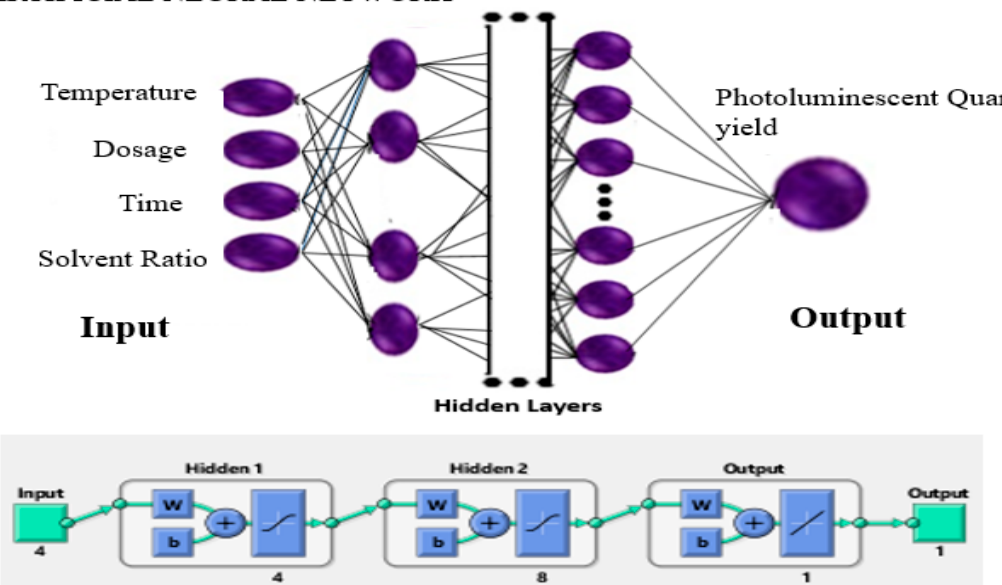
Figure 1. Architecture of multilayer perceptron neural network.